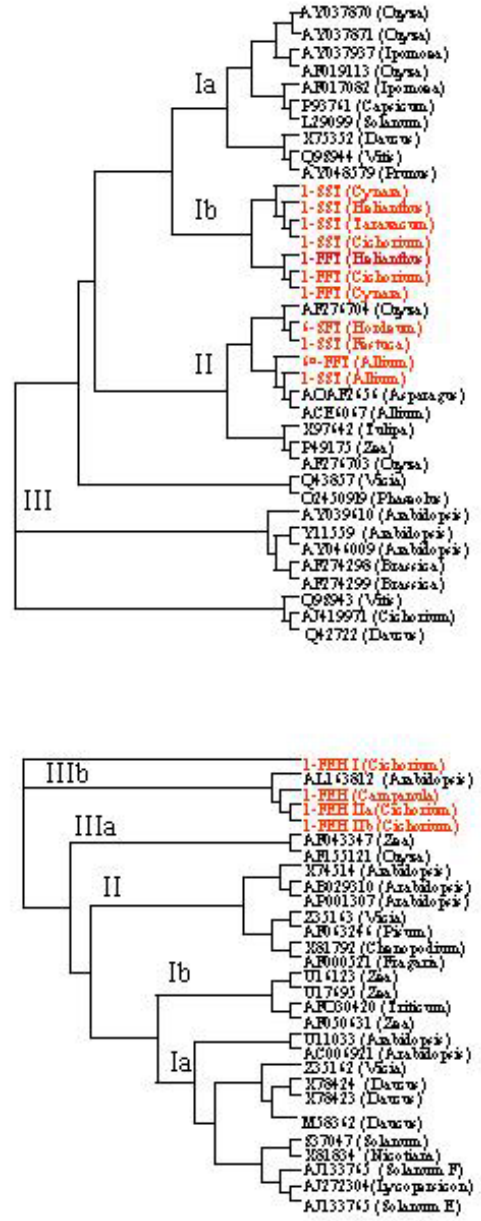
FIGURE 2. Rooted phylogenetic trees containing cDNA-derived amino acid sequences of plant vacuolar-type invertases and fructosyltransferases and cDNA-derived amino acid sequences of plant cell-wall–type invertases and FEHs. Within the vacuolar enzymes (A) , three groups can be discerned. First group (Ia): invertases of Oryza sativa, Ipomoea batatas, Capsicum annuum, Solanum tuberosum, Vitis vinifera , Daucus carota, and Prunus cerasus. First group (Ib): dicot fructan biosynthetic enzymes 1-SST and 1-FFT from Helianthus tuberosus, Cichorium intybus, and Cynara scolymus and 1-SST from Taraxacum officinale . Second group (II): monocot fructan biosynthetic enzymes and invertases from Hordeum vulgare (6-SFT), Allium cepa (1-SST, 6 G -FFT and invertase), Festuca arundinacea (1-SST), Asparagus officinalis, Zea mays , Tulipa gesneriana, and Oryza sativa. Third group (III): all other dicot invertases of Cichorium intybus , Daucus carota , Arabidopsis thaliana , Brassica oleracea, Vicia faba , Phaseolus aureus, and Vitis vinifera . Within the cell-wall invertases (B), three groups can be differentiated. First group (Ib): monocot cell-wall invertases from Zea mays and Triticum aestivum . First group (Ia): dicot cell-wall invertases from Vicia faba, Daucus carota, Solanum tuberosum, Lycopersicon esculentum, Arabidopsis thaliana, and Nicotiana tabacum . Second group (II): dicot cell-wall invertases from Arabidopsis thaliana, Vicia faba, Pisum sativum, Chenopodium rubrum, and Fragaria × ananassa . Third group (IIIa): low pI cell-wall invertases from Zea mays and Oryza sativa. Third group (IIIb): low pI Arabidopsis thaliana fructosidase and 1-FEHs from Cichorium intybus (1-FEH I, IIa, and b) and Campanula rapunculoides . Plant fructan metabolic enzymes are indicated in red. All other cDNA- derived sequences are believed to represent invertases. Their accession number is